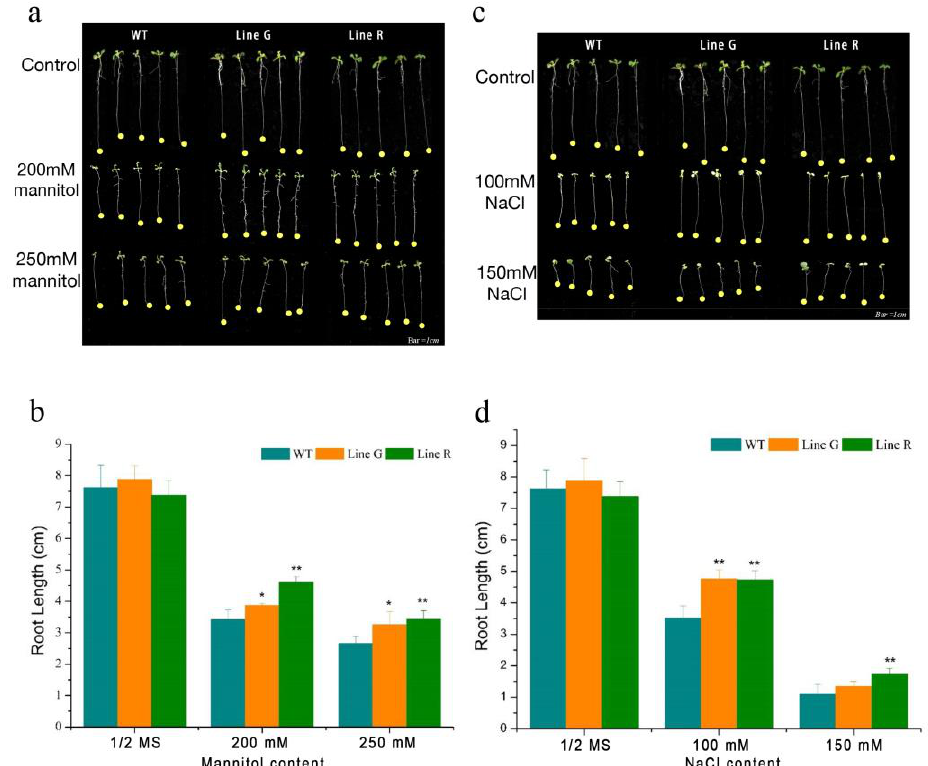
Figure 2. Phenotypic analyses of MfPIF8 transgenic lines and WT under drought and salt treatments at the seedling stage. ( a , b ) Morphology and primary root length measurement of OE and WT seedlings grown on 1/2 MS medium with varying contents of mannitol for nine days. ( c , d ) Morphology and primary root length measurement of OE and WT seedlings grown on 1/2 MS medium with varying contents of NaCl for nine days. Data are presented as mean and SD values of three independent experiments. Asterisks indicate significant difference (* p < 0.05, ** p < 0.01, by independent sample t -test) compared with WT.